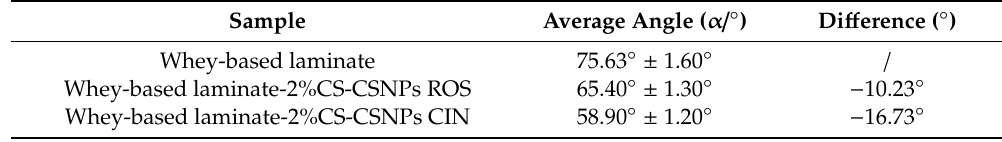
Table 1. Contact angles of whey-based laminates.